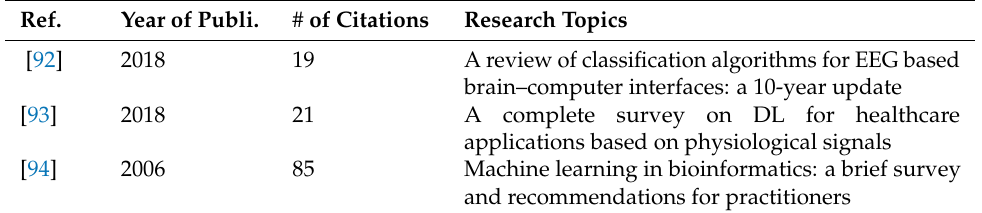
Table 3. Survey papers on deep learning in brain and body machine interfaces.